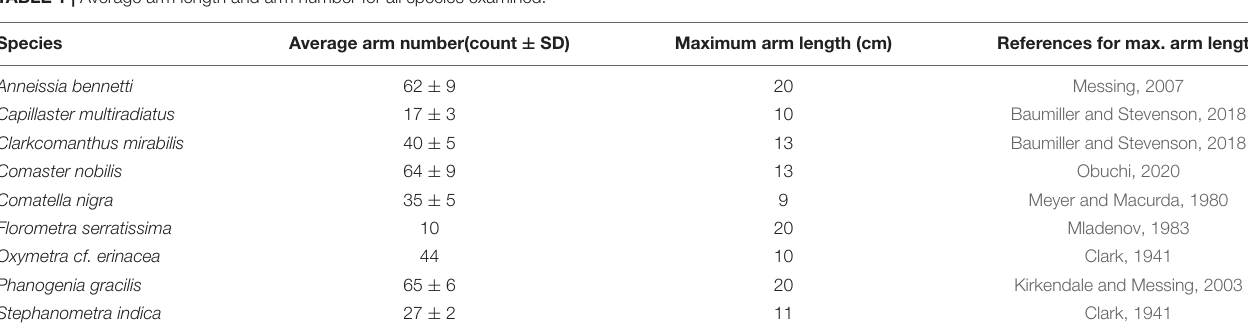
TABLE 1 | Average arm length and arm number for all species